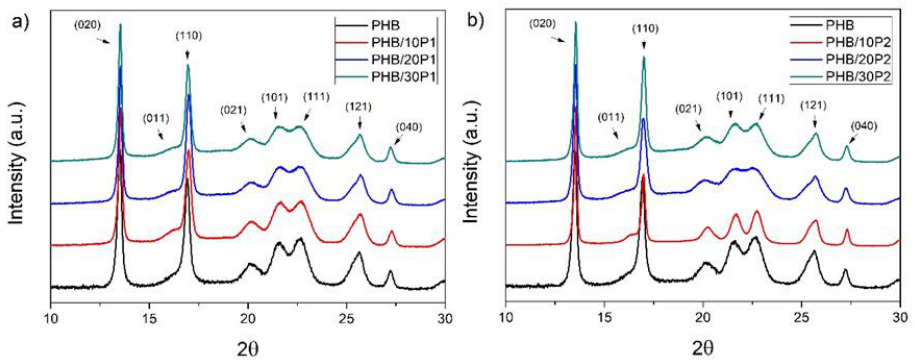
Figure 8. XRD spectra of PHB, PHB/P1 ( a ), and PHB/P2 ( b ) blends. Table 4. Calculated crystallinity index of PHB, PHB/P1, and PHB/P2 blends using DSC (X DSC ) and XRD (X XRD ) data.